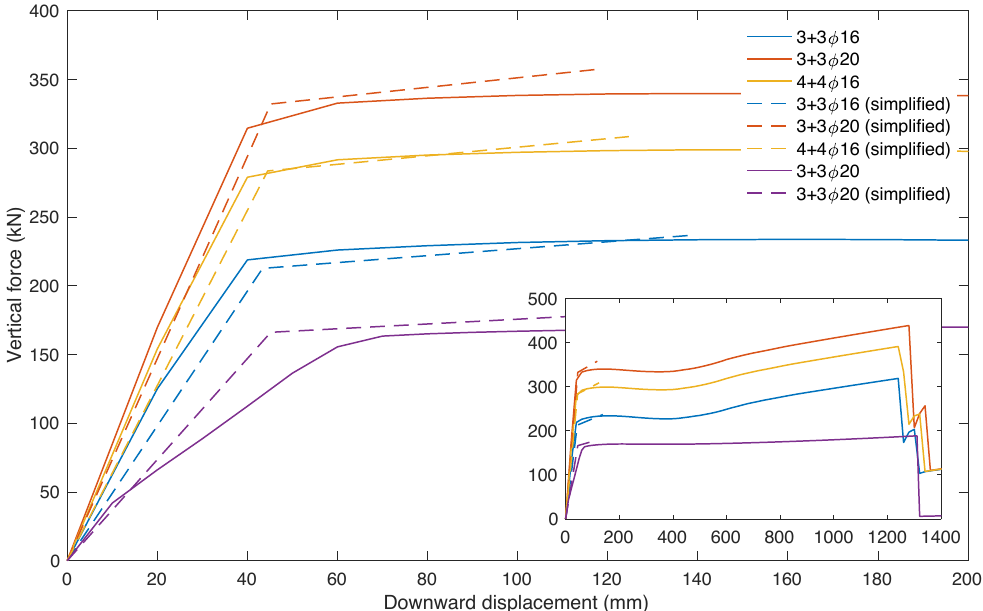
Figure 9. Compliance curves for the four reinforcement amounts in the beams and column removal position. Solid lines (–) correspond to the FE simulations, while dashed lines (- -) to the simplified bilinear compliance law. The downward displacement is limited to 200 mm in main plot, while the secondary axes (that have the same labels as the primary ones) depict the full pushdown analysis up to 1400